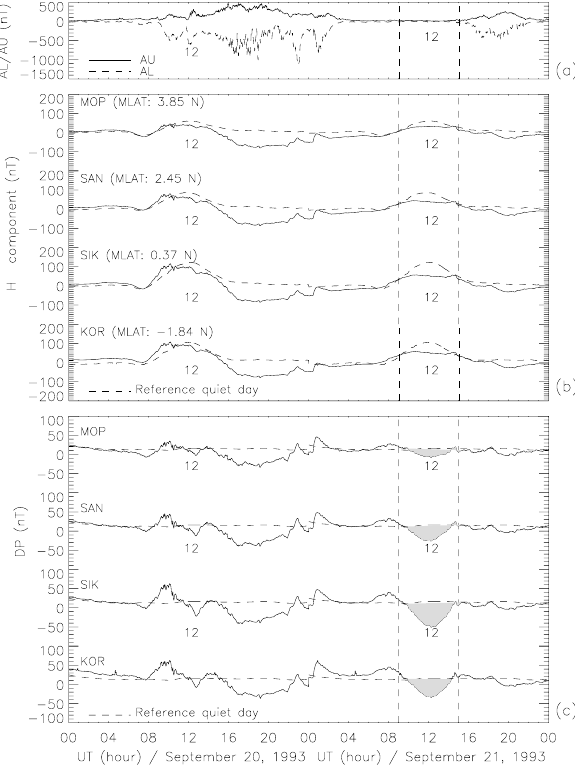
Fig. 4. Idem as Fig. 3, for the magnetic storm on 20, 21 September